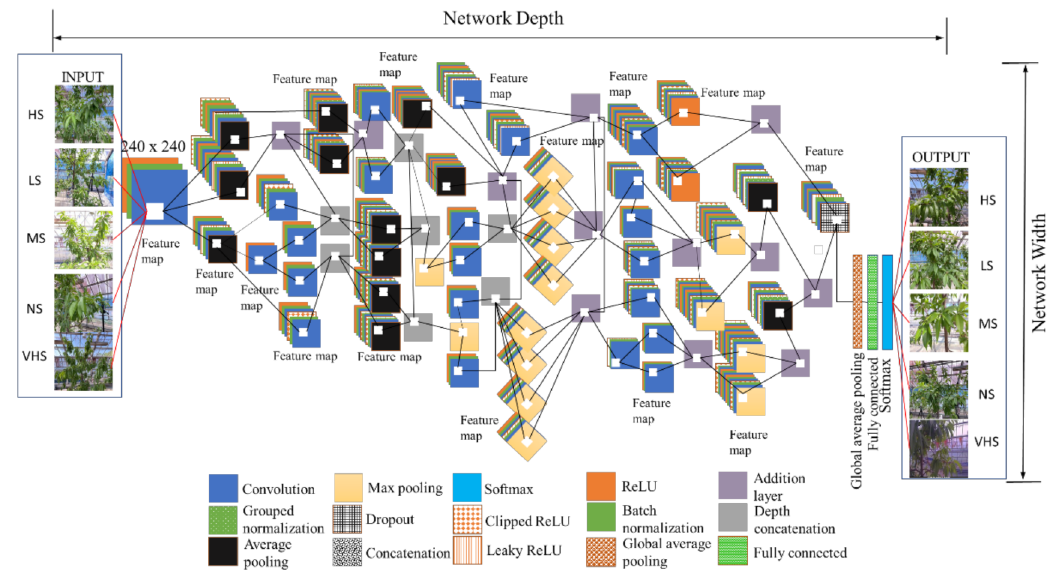
Figure 3. HortNet417v1 network architecture (HS—high stress, LS—low stress, MS—moderate stress, NS—no stress, VHS—very high